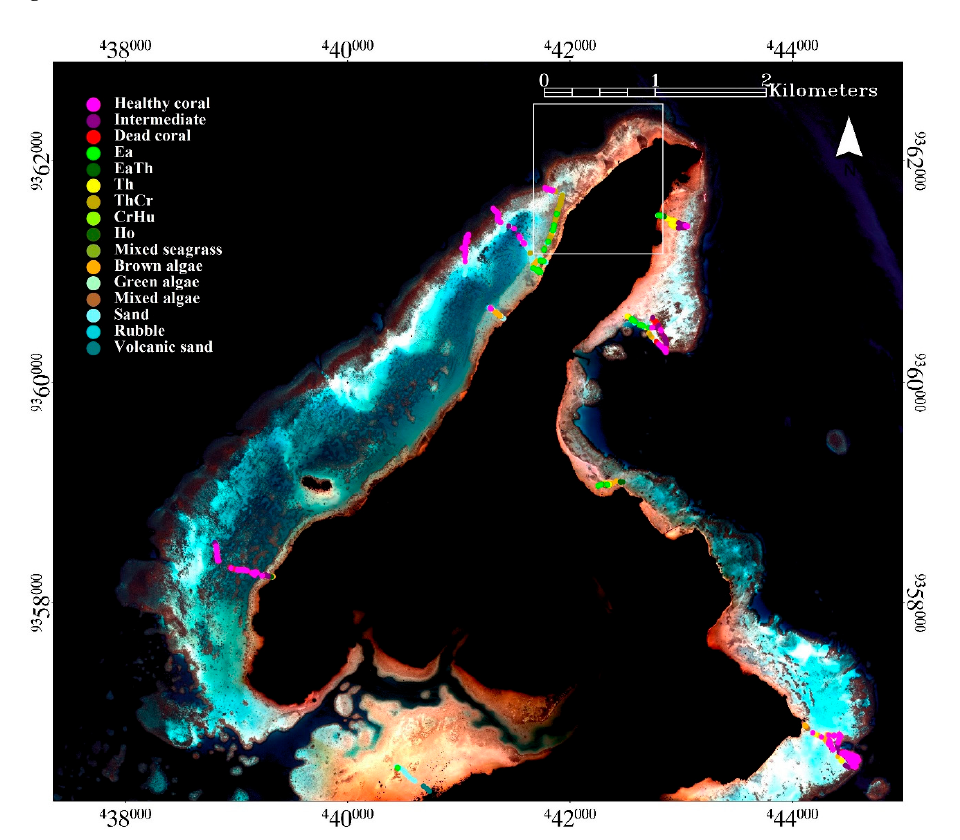
Figure 2. Benthic habitat samples collected in the field using photo-transect method. White box indicates the location of subset area in Figure 4.